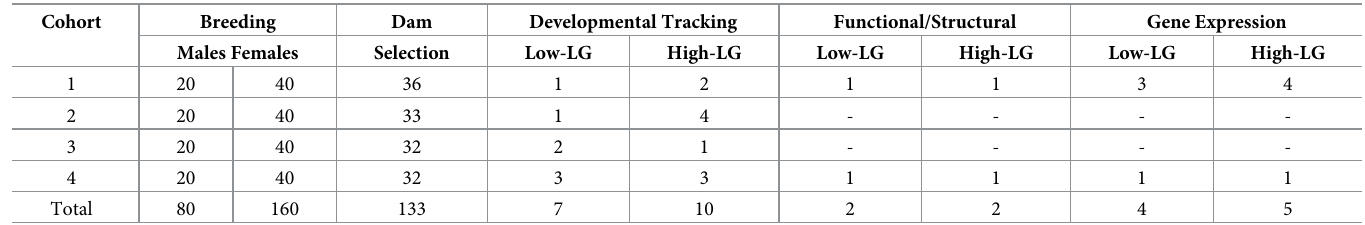
Table 1. Number of adult rats used in experiments. Cohort Developmental Tracking